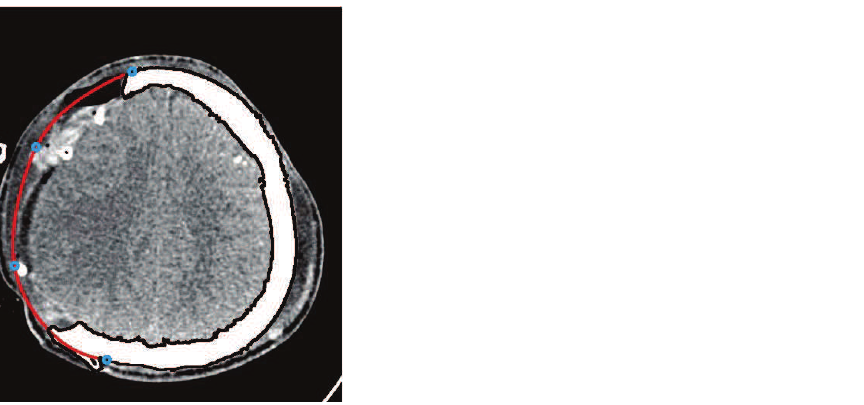
Figure 19. Construction of fractured part curve using GC 2 rational Ball curves with three